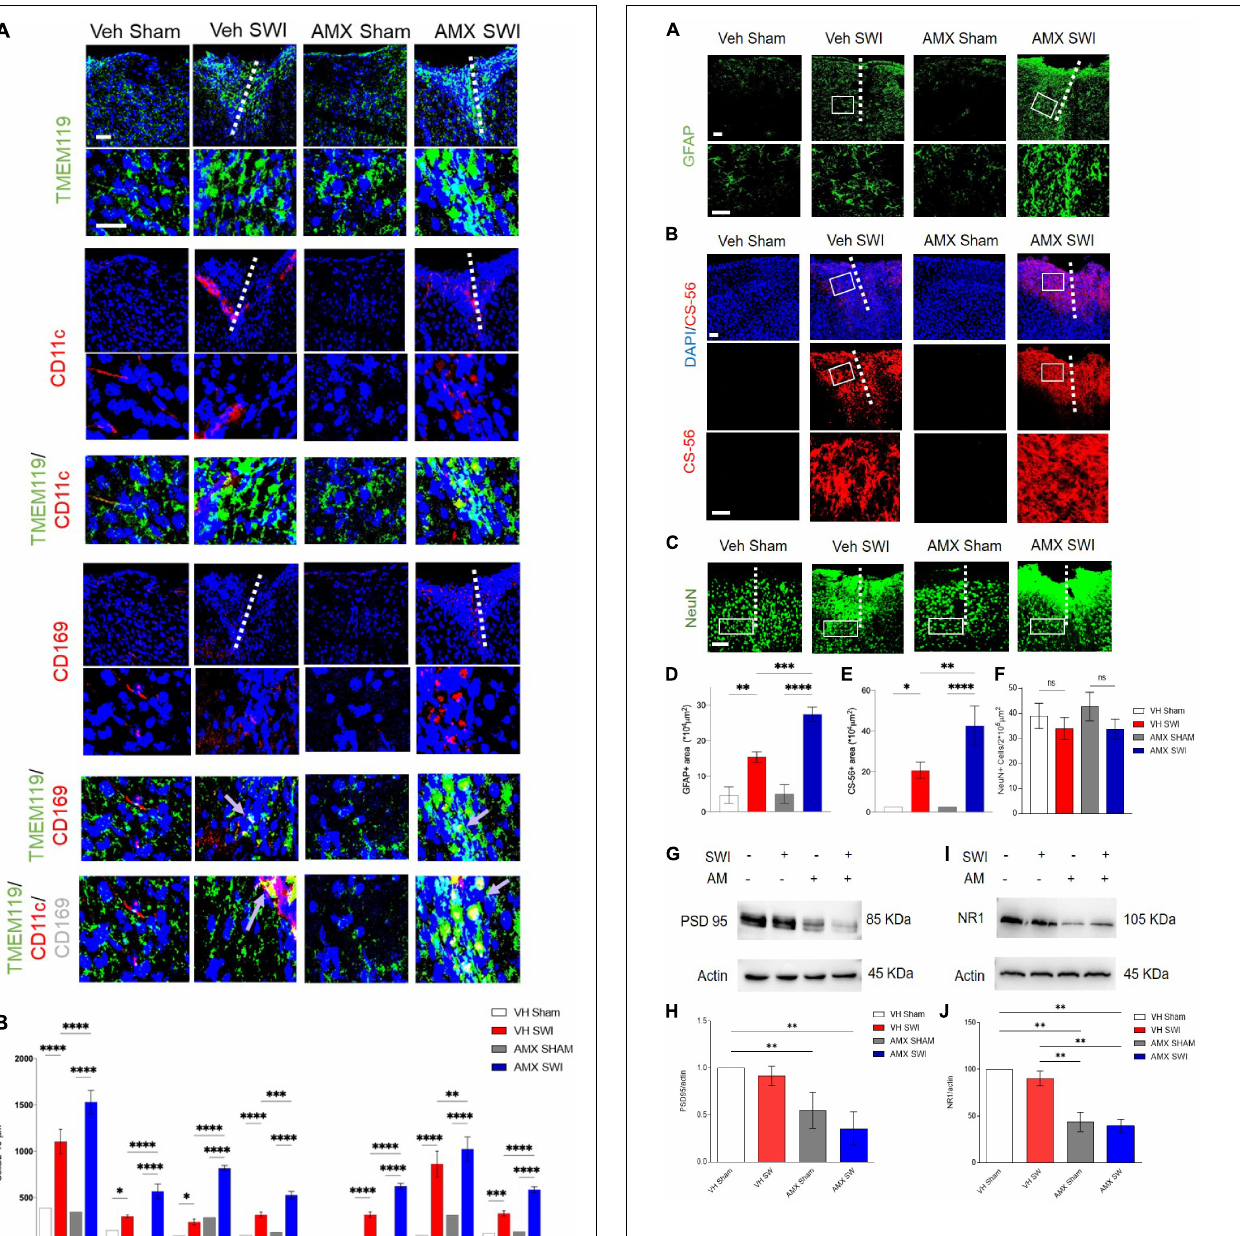
FIGURE 9 | Tbk1 blockade enlarges the gliotic scar and amplifies the deposition of CPSG at 7dpi after Stab Wound Injury (SWI). (A,D) The density of reactive astrocytes (GFAP + ) is substantially larger at 7 dpi in mice treated with AMX for 7 days after SWI compared to vehicle-treated controls. (B,E) The extent of the CSPG scar deposition (as revealed by immunostaining with the CS-56 antibody) is substantially increased by the treatment with AMX for 7 days after SWI injury. (C,F) The density of NeuN + cells is unaffected by either vehicle or AMX treatment. Western blots of cortical biopsies (at 7 dpi) homogenates show decreased levels of (G,H) PSD-95 and (I,J) NR1. ( n = 3 animals/group with 4 sections/animal. n = 4 animals for the vehicle treated group and n = 6 animals for the amlexanox treated group. Average ± SD; one-way ANOVA with Tukey post hoc ; ns: not significant, ∗ p < 0.05, ∗∗ p < 0.01, ∗∗∗ p < 0.001, ∗∗∗∗ P < 0.0001; original uncropped blots in Supplementary File 2 ; full statistical report in Supplementary Table 11 ). Length of scale bars for both low-magnification and high-magnification insets is 200 µ